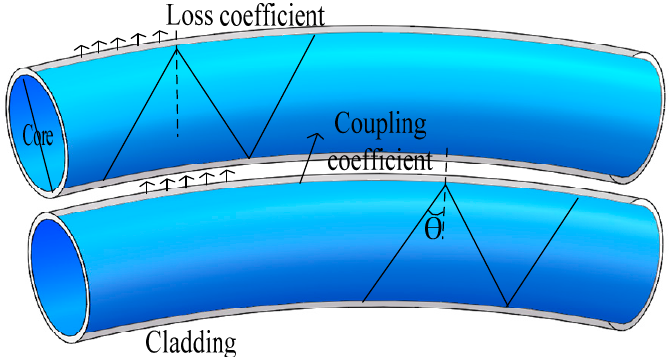
Figure 2. Macro-bend coupling effect between two fibers.